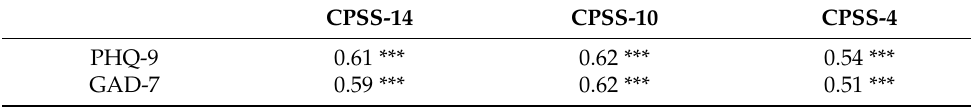
Table 4. Correlations between three versions of the CPSS and criterion-related measures. CPSS-14 CPSS-10 CPSS-4